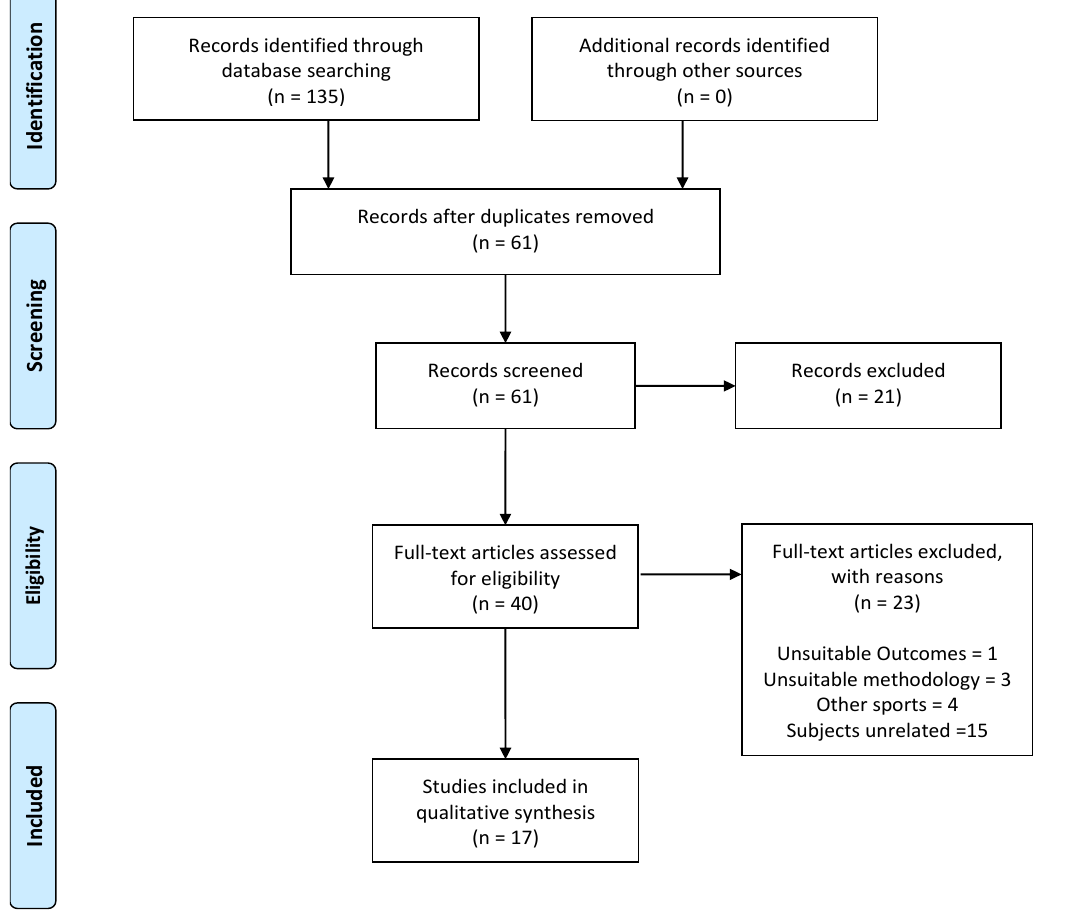
Figure 1. Selection of studies.